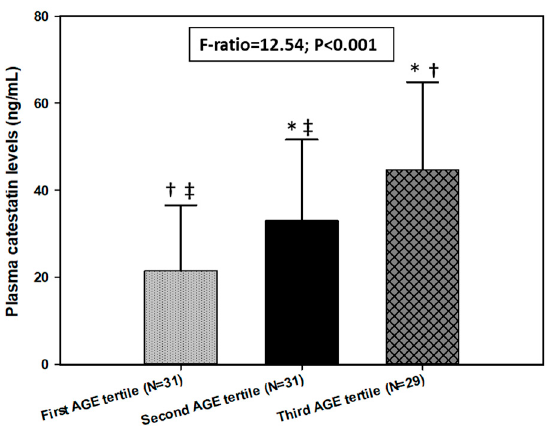
Figure 4. CST levels between tertiles of AGE levels. Abbreviations: AGE, advanced glycation end product. Tested with one-way analysis of variance (ANOVA) with post hoc Sceffé test to examine differences between each of the groups. *, p < 0.05 vs. first AGE tertile. †, p < 0.05 vs. second AGE tertile. ‡, p < 0.05 vs. third AGE tertile.